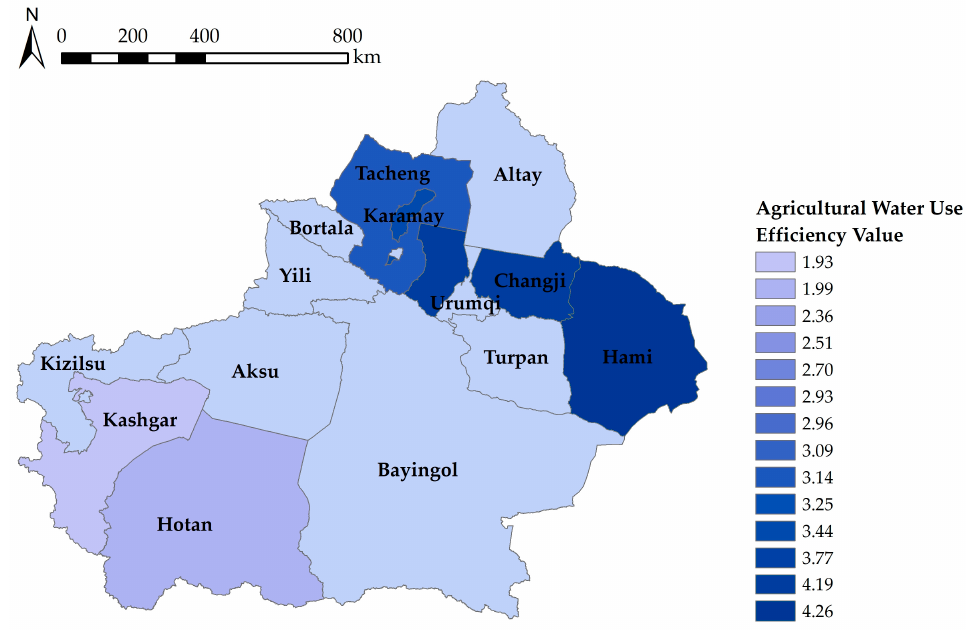
Figure 3. Distribution map of agricultural water use efficiency values in 14 administrative regions.